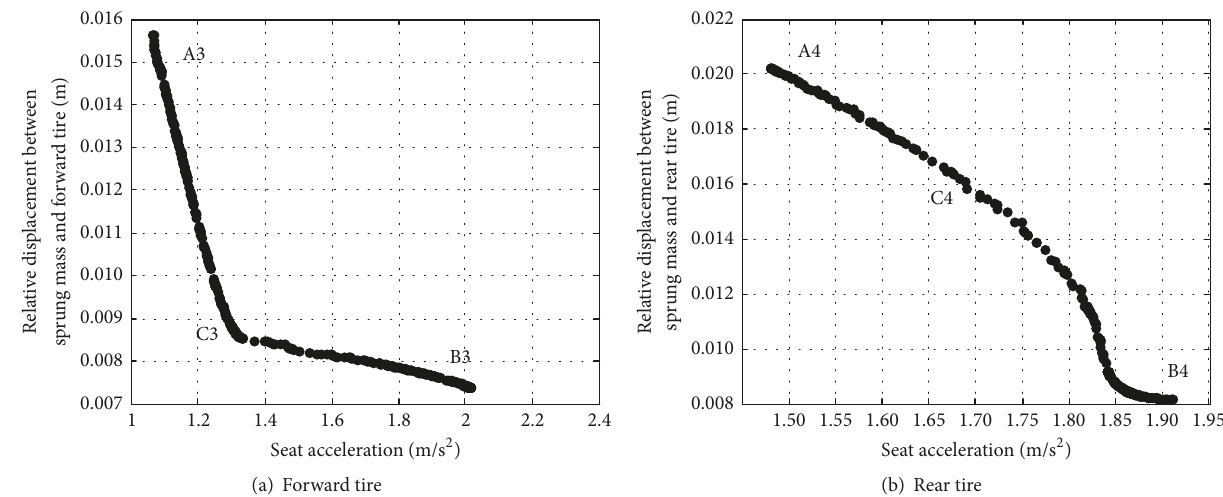
Figure 16: Pareto front for seat acceleration and relative displacement between sprung mass and forward/rear